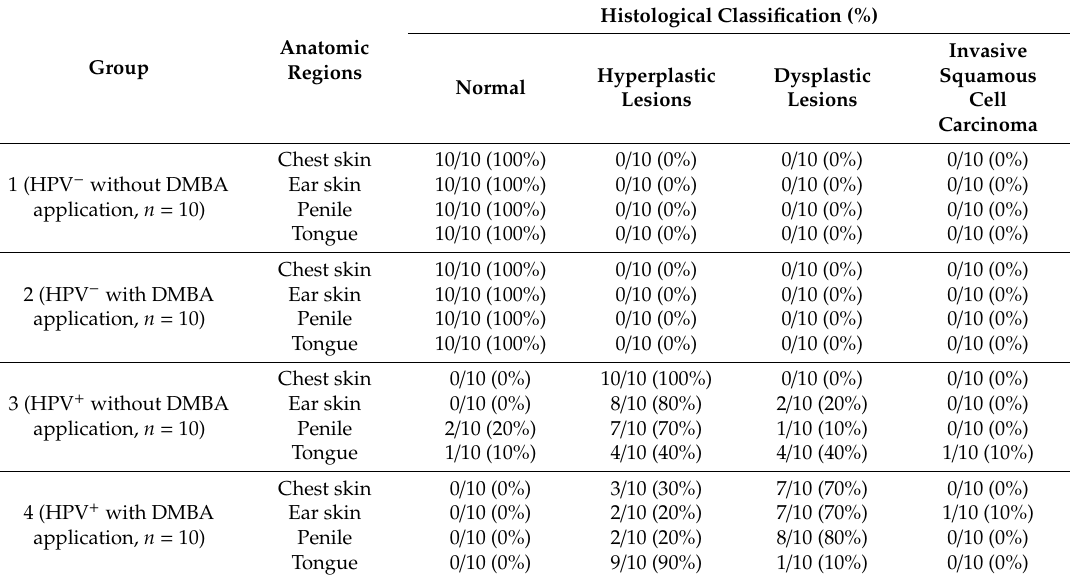
Table 1. Histological classification of mouse samples.